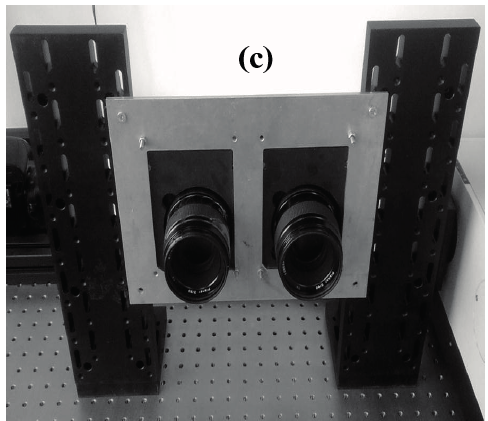
Figure 4. Prototype system of the novel MDCS: ( a ) structure diagram; ( b ) installation in the Yun-5 aircraft for flight experiment; and ( c ) installation in the optical platform for calibration.